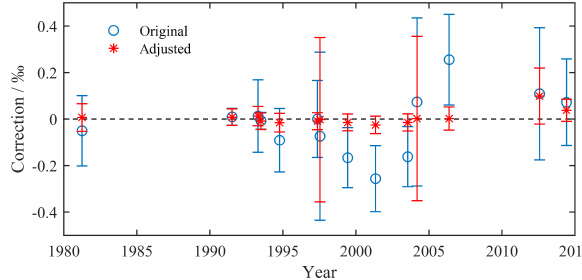
Figure 5. The results of the WDLSQ based inversion routine for the original (blue circles) and the adjusted dataset (red stars). The cruises are plotted at the time the data were collected vs. the sug- gested